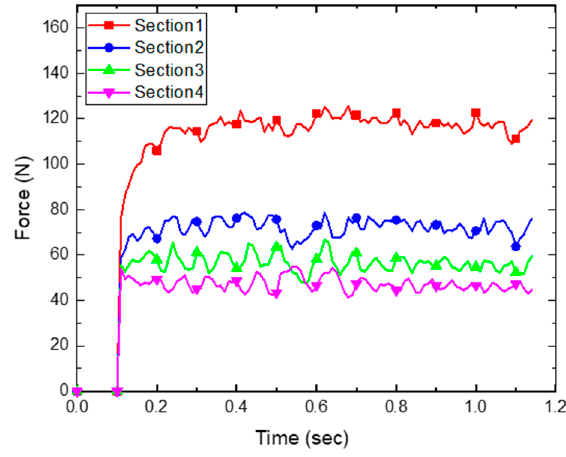
Figure 20. History of total tangential forces in each section.